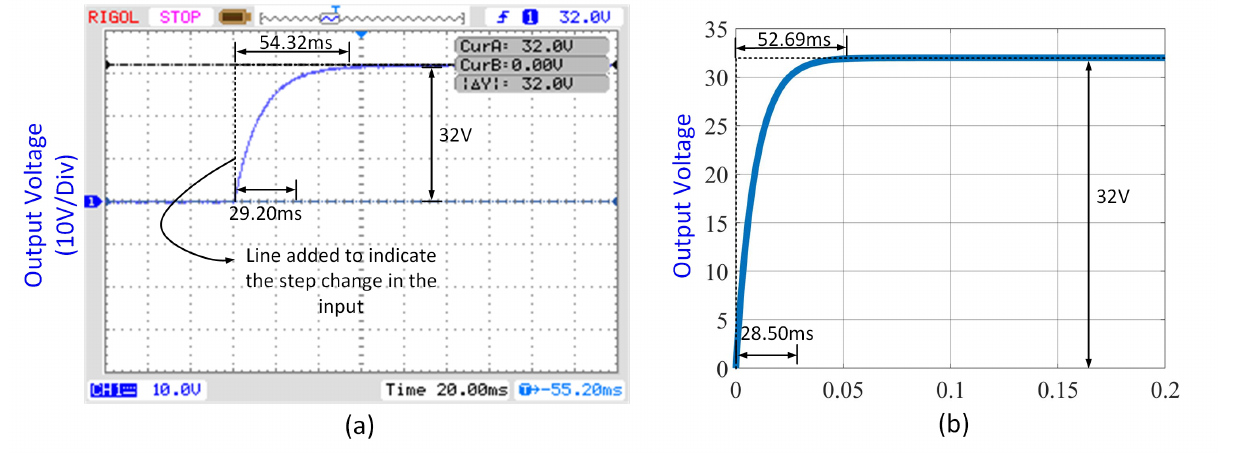
Figure 5. Results using conventional PI controller with fuel cell. ( a ) Hardware results. ( b ) Simulation results.